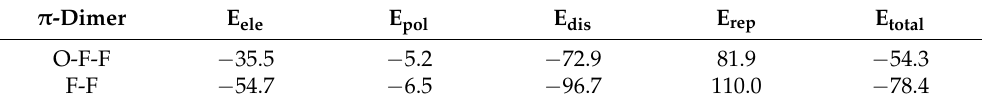
Figure 15. Crystal Explorer interaction energies (in kJ/mol) for the two halogen bonding interac- tions within cocrystal 2•3 . Table 4. C-I-N angles and interaction energies (in kJ/mol) between halogen bonded molecules in cocrystal 2•3 . r XB (Å)